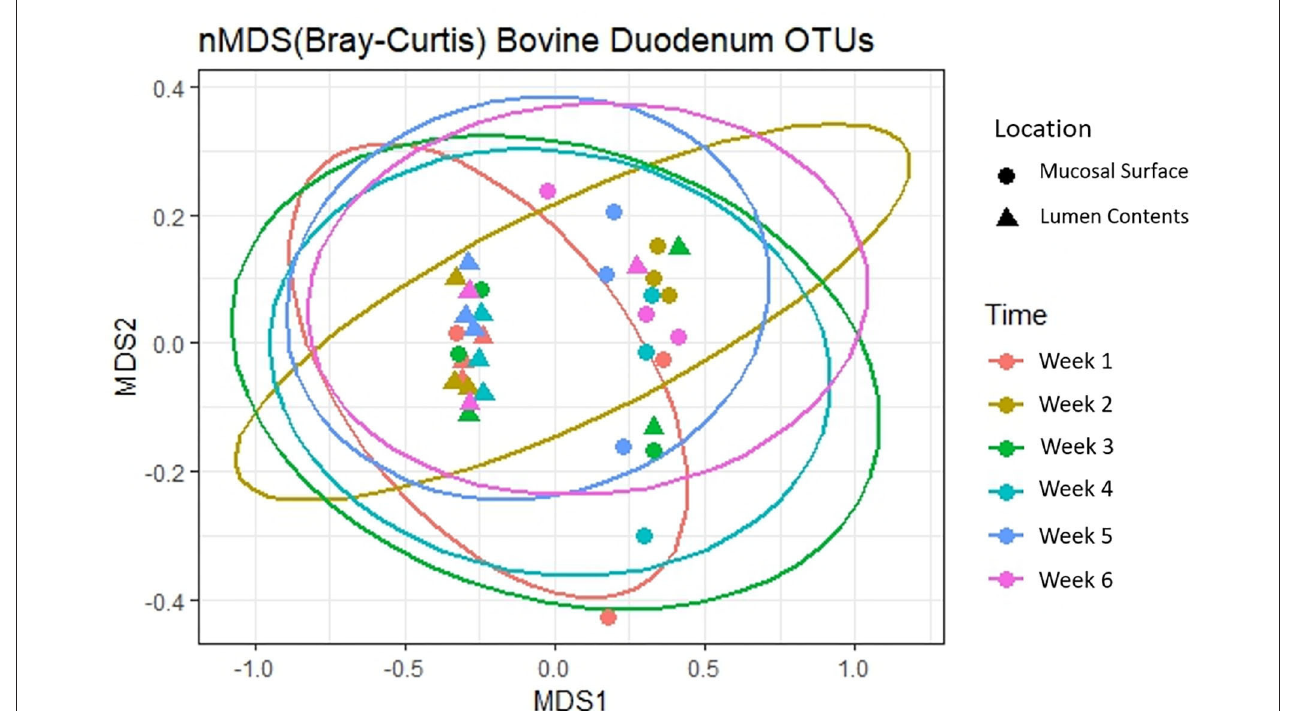
FIGURE 3 | Multidimensional scaling plot (MDS) of bacterial lineages in the mucosal surface and lumen contents.